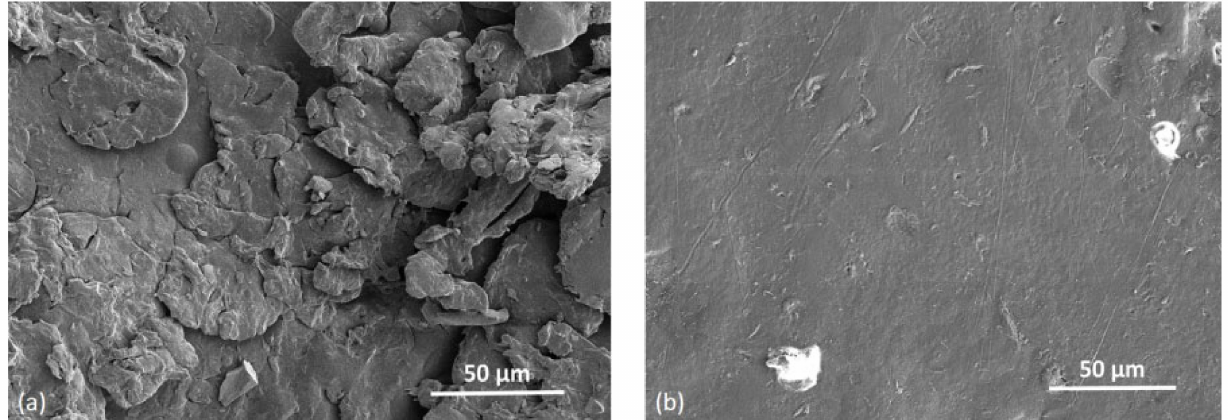
Figure 12. ( a ) SEM picture of the top side of a tensile bar of PET manufactured by HSS with bed tem- perature of 195 ◦ C, showing unmelts; ( b ) SEM picture of the top side of a PET specimen manufactured from the same powder by LS with the bed temperature at 227 ◦ C, showing fewer